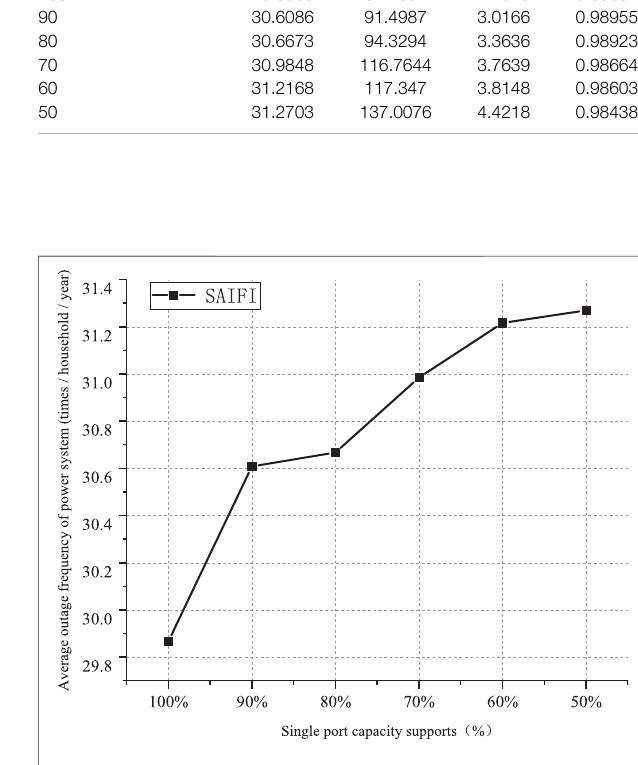
FIGURE 16 | Analysis and comparison of the impact of PET port capacity on SAIFI.